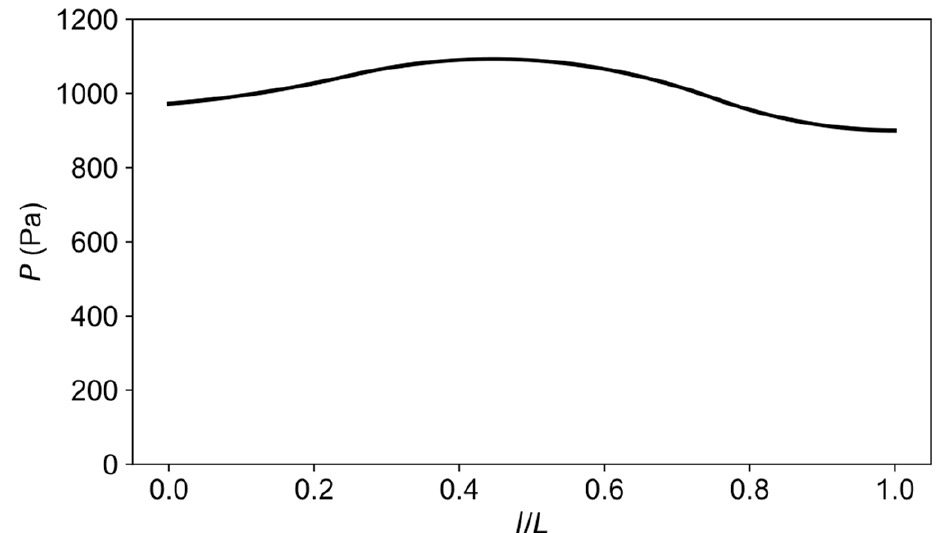
Figure 16. Optimized pressure distribution along the longitudinal direction of the pipe.